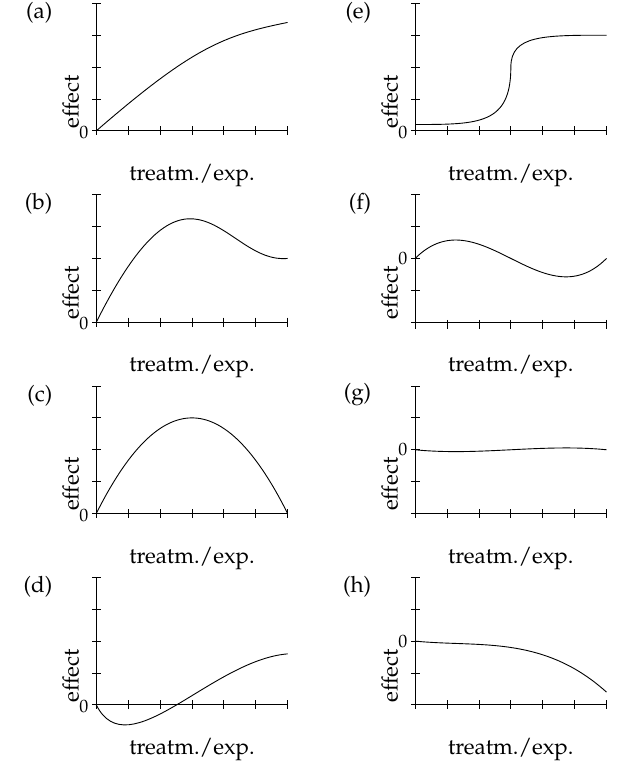
Figure 3. Possible functional forms of the relationship between D and E . Adapted from [22] (Figure